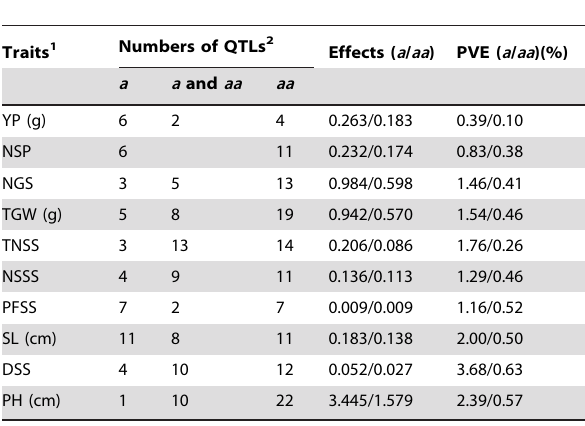
Table 6. Numbers, main effects and contributions of QTLs for yield-associated traits in wheat DH lines.